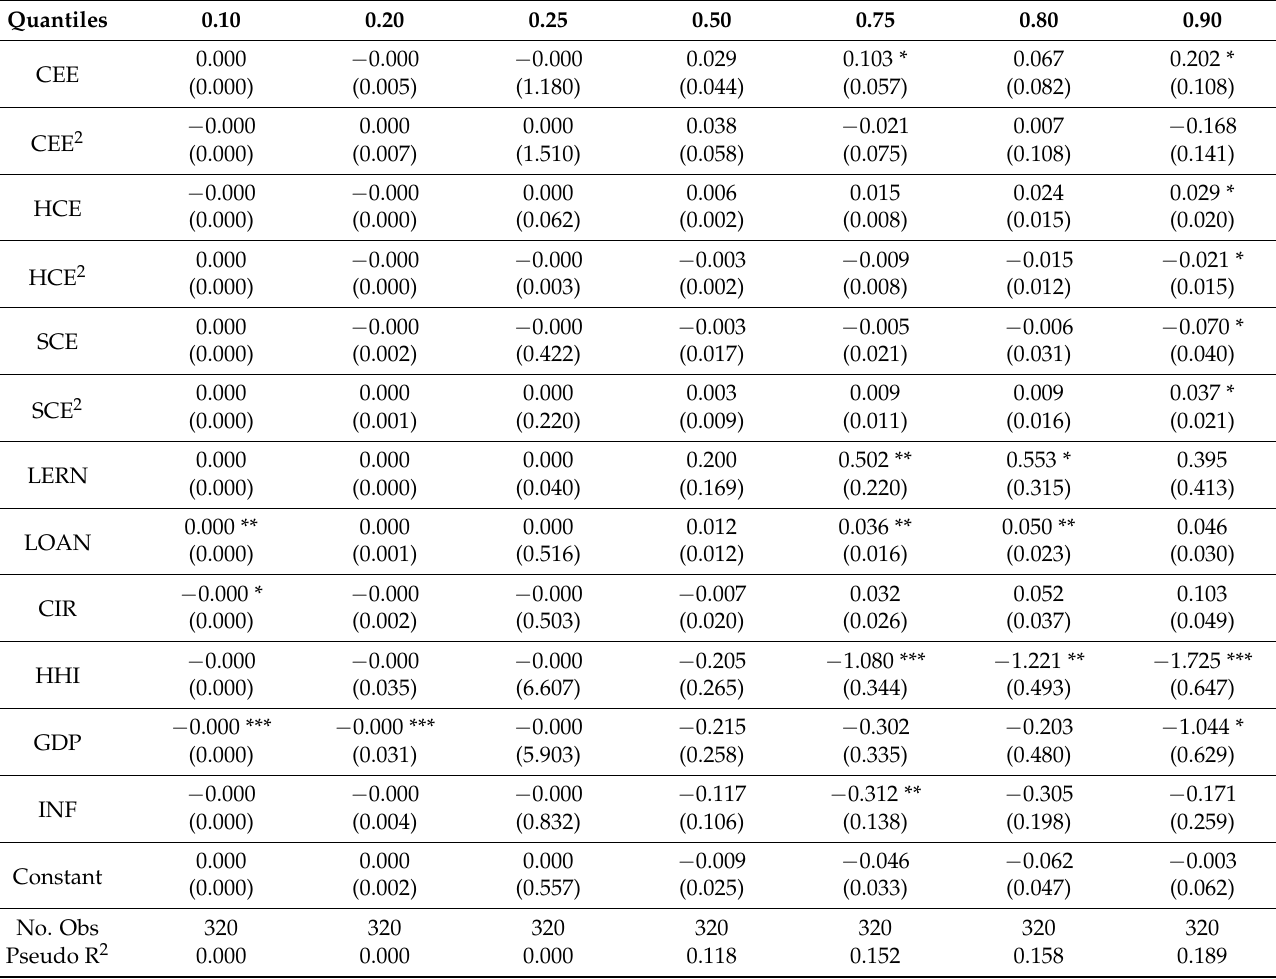
Table 6. Baseline results for Z and VAIC’s components: Quantile